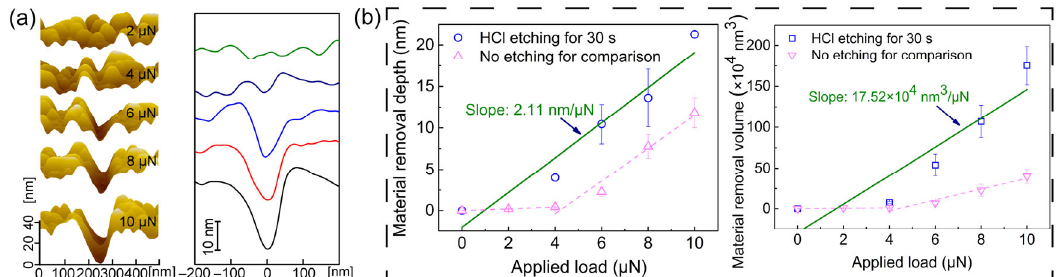
Fig. 4 (a) Typical AFM surface topographical images and average cross-section profiles of the material removal traces after performing wear tests on the oxide-free pure iron surface treated with a dilute HCl solution at pH 1.5 against a diamond tip in vacuum. (b) Corresponding statistical data for the amount of removed material and comparison with the results of the polished pure iron sample as presented in Fig.